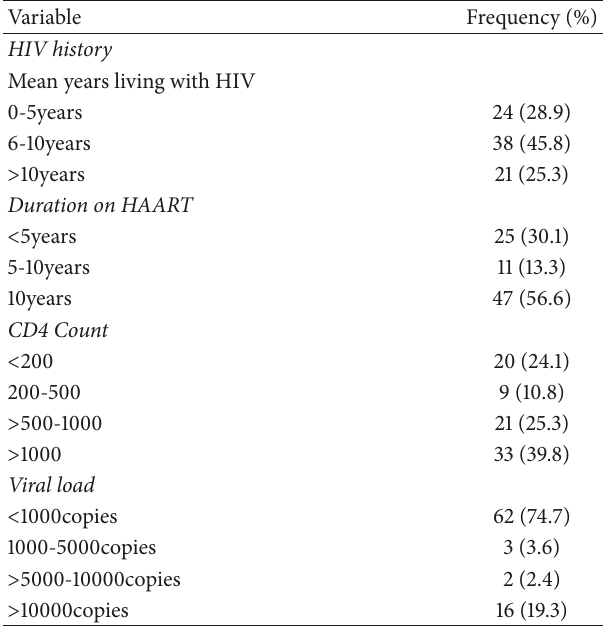
Table 2: Clinical characteristics of Children living with